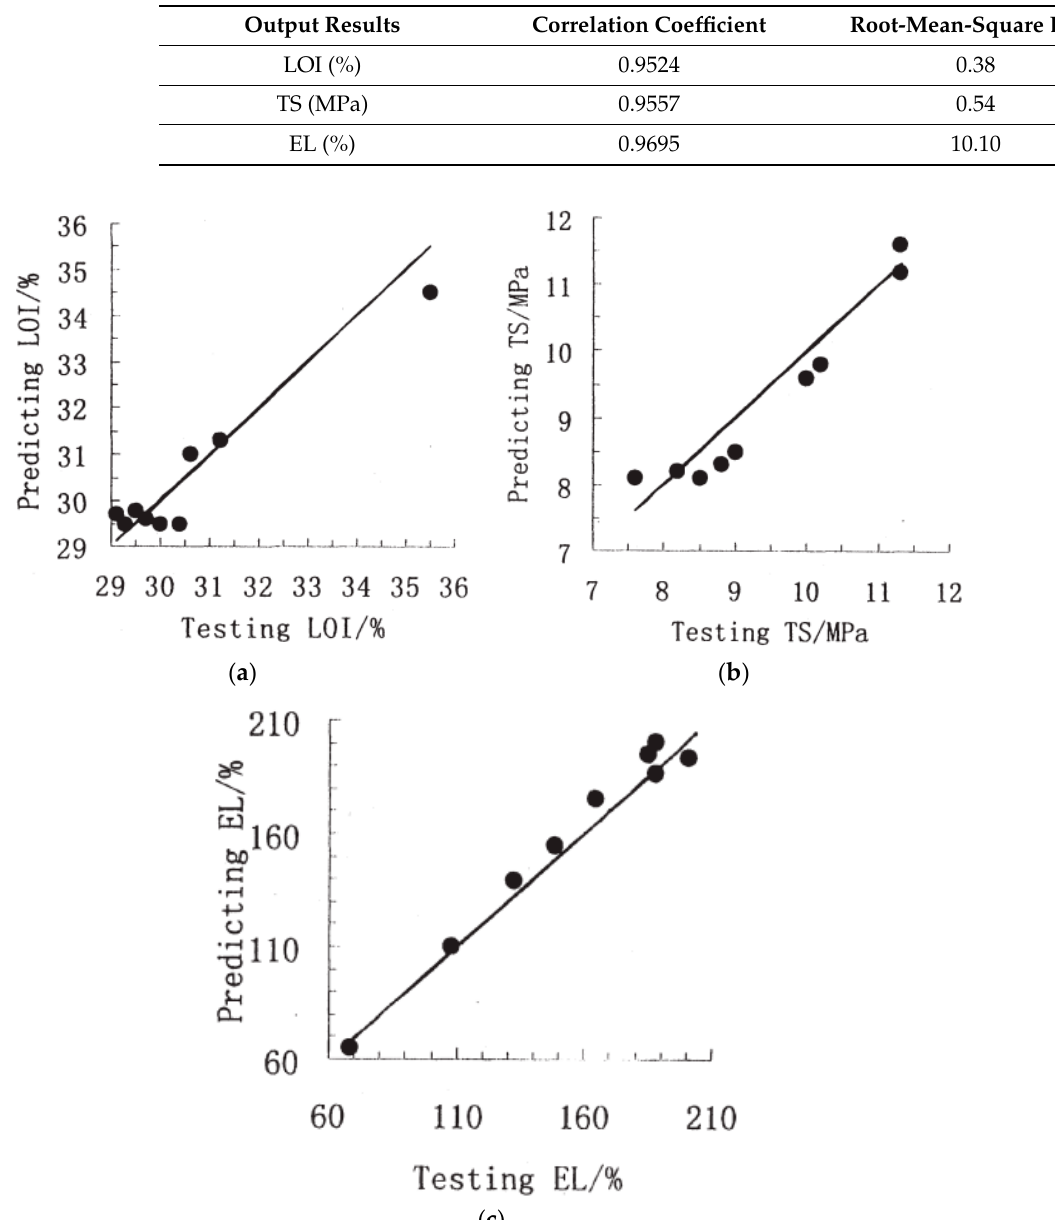
Figure 12. The correlation between the predicted and observed values of the ( a ) LOI, ( b ) TS, and ( c ) EL of the samples in the test set. Adapted with permission from ref. [102]. Copyright 2001 Journal of Fire Sciences.